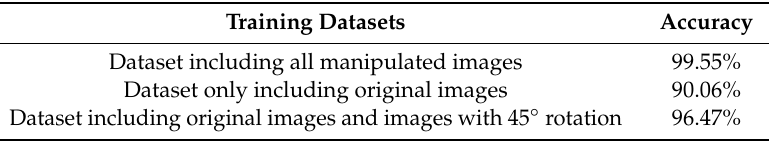
Table 4. Comparison of the results in di ff erent training